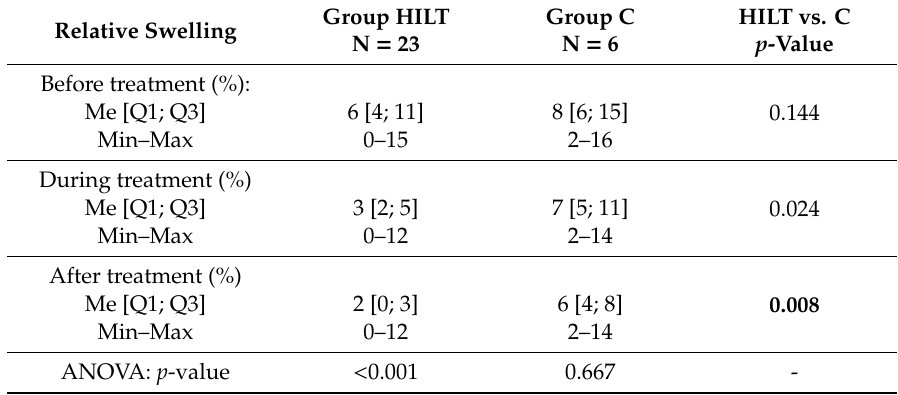
Table 2. The effect of HILT on relative swelling (median and IQR) for horses from group HILT and group C.